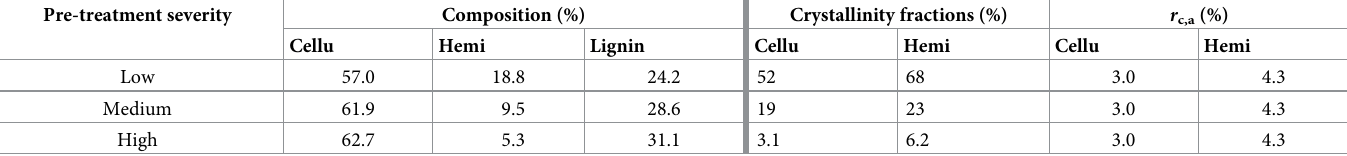
Table 1. Parameters for the substrate composition, crystallinity fractions, and digestibility ratios ( r c,a ) at three pre-treatment severities (low, medium and high). The composition is closely derived from experimental data: the percentages of hemicellulose and lignin are from Bura et al. [11], while the glucose percentages are adapted such that the composition percentages sum up to 1. The crystallinity fractions and digestibility ratios r c,a are determined by fitting the experimental saccharification time courses by Bura et al. [11] (see section